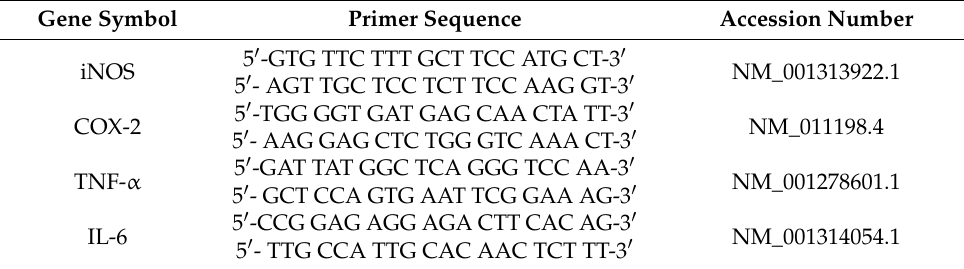
Table 1. Oligonucleotide sequences used in qRT-PCR experiments. Gene Symbol Primer